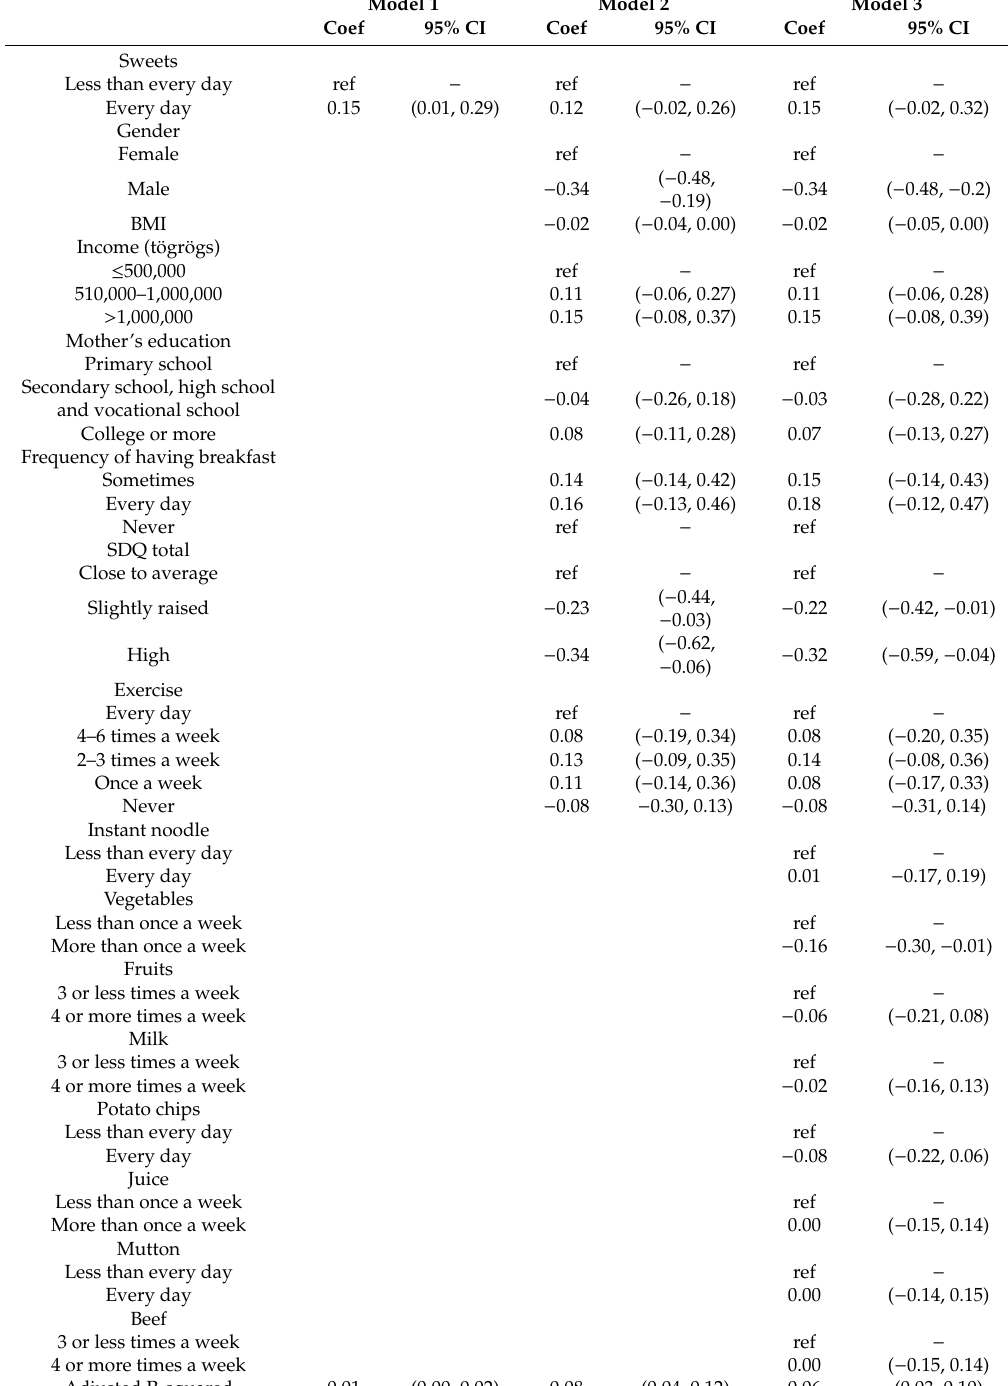
Table 2. Linear regression results for sociodemographic and dietary factors associated with academic performance in mathematics; multiple imputation applied ( n =